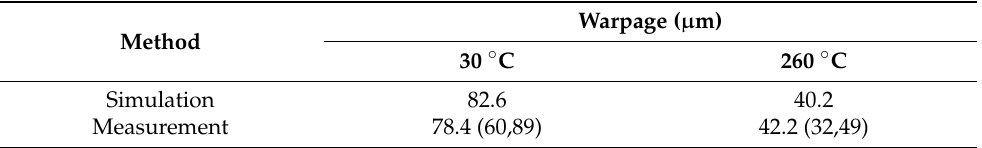
Figure 13. Comparison of simulated and experimental warpages after the mold cure process; ( a ) simulation; ( b ) experiment. Table 7. Warpage comparison between the simulation and measurement.